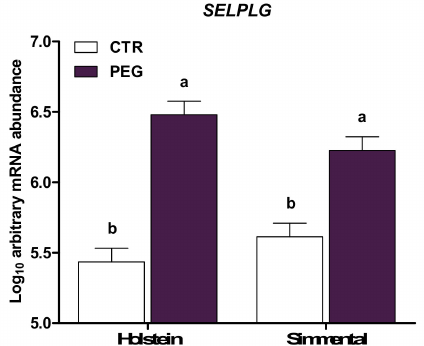
Figure 2. LSM ± SEM of Log10 arbitrary mRNA abundance for gene expression of SELPLG (selectin P ligand) evaluated three days after calving in Simmental and Holstein cows treated either with pegbovigrastim (PEG) or with saline (CTR) at approximately Day 7 relative to calving and on the day of calving within 24 h. Di ff erent letters represent significant di ff erences among groups at p ≤